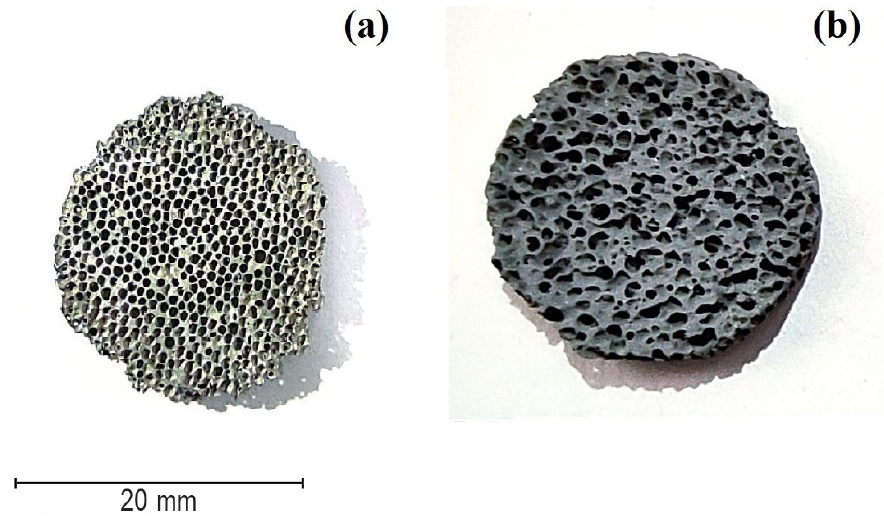
Figure 4. Obtained open-cell aluminum foam by SPS ( a ), by replication method ( b